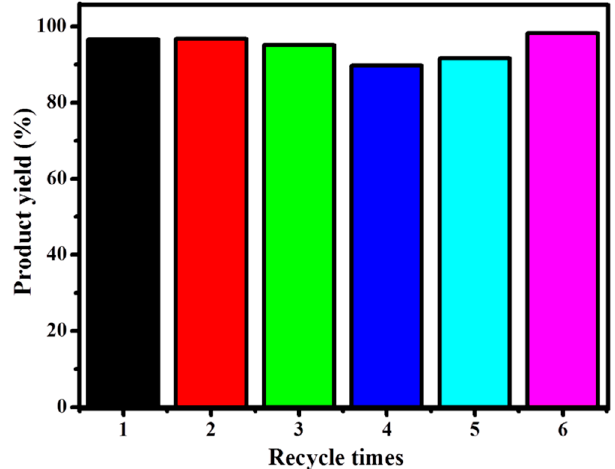
Figure 5. Examination of reusability of B-L MIL 5c (under reaction temperature = 80 °C, a reaction time = 0.5 h, 5c amount = 1.0 mole %, and a molar ratio (p-xylene:BnCl) = 6:1).